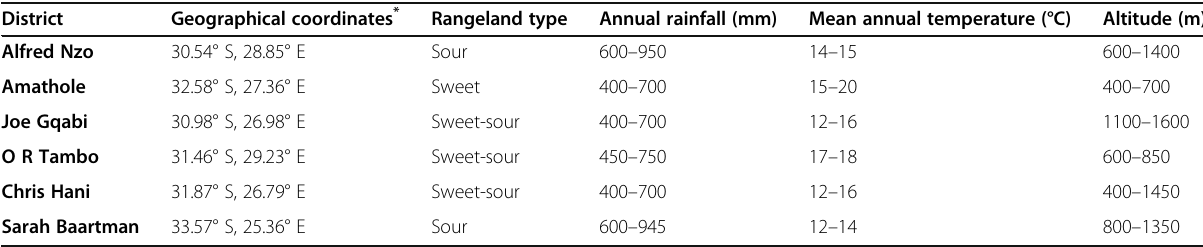
Table 1 The geographical coordinates and pedo-climatic conditions of the study areas District Geographical coordinates * Rangeland type Annual rainfall (mm) Mean annual temperature